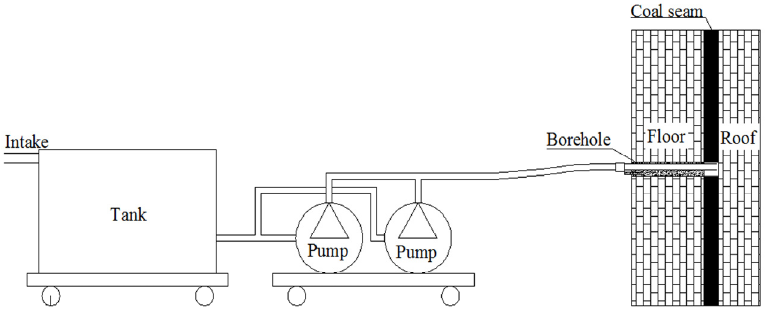
Figure 7. The connected equipment of the high-pressure hydraulic fracturing system.